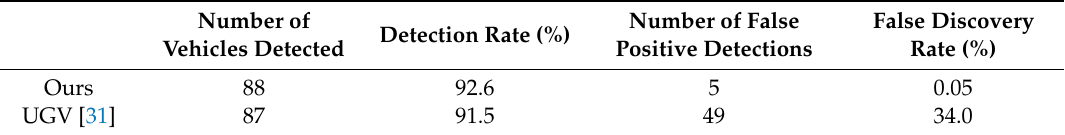
Table 6. Detection analysis compared with a commercial mobile